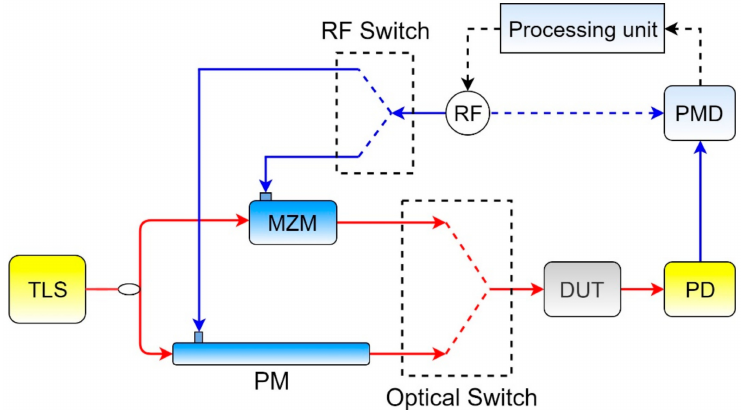
Figure 7. The schematic diagram of the OVA based on symmetric ODSB and di ff erent modulation schemes: TLS—tunable laser source; MZM—Mach–Zehnder modulator;